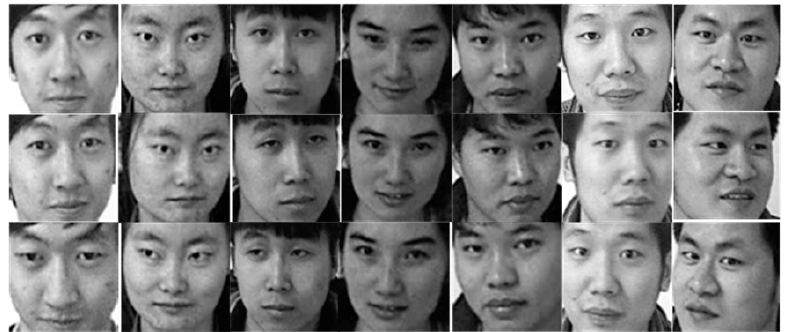
Figure 4. Our newly collected dataset. There are 3398 images of 47 subjects in the database, where 400 images come from the original ORL database, and 2998 images are expanded by us.